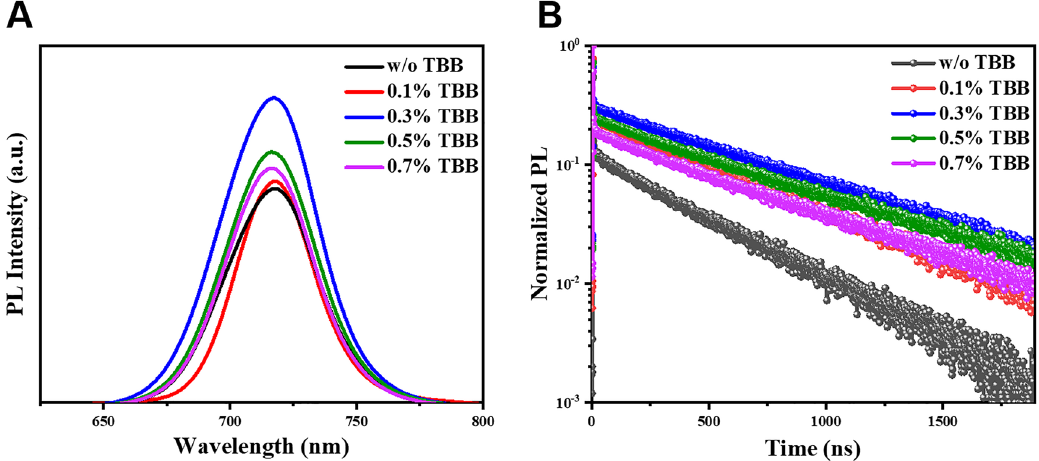
Figure 3: Photoluminescence (PL) characterizations of perovskite samples doped with different concentrations of 1,3,5-tris (bromomethyl) benzene